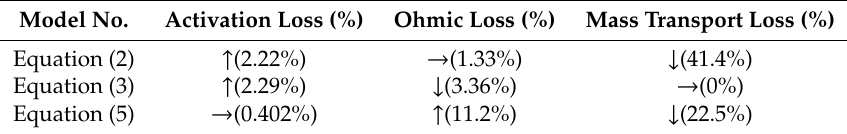
using di ff erent arrows, ↑ :increase; ↓ :decrease; → : almost no variation).